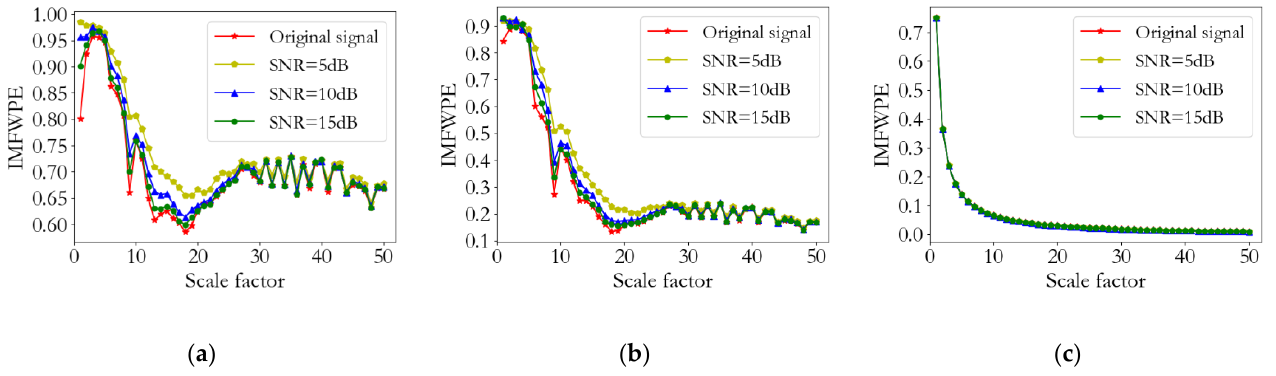
Figure 3. Vibration signals with different signal-to-noise ratios: ( a ) original signal; ( b ) noisy signal (SNR = 15 dB); ( c ) noisy signal (SNR = 10 dB); ( d ) noisy signal (SNR = 5 dB).